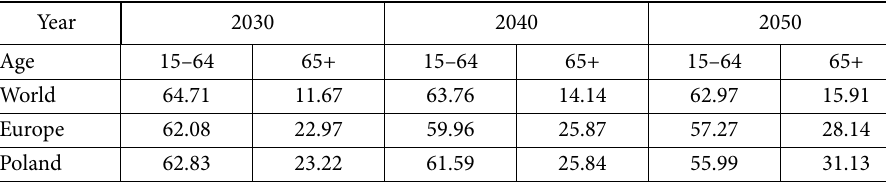
Table 1. Population by age groups [%] (United Nations,